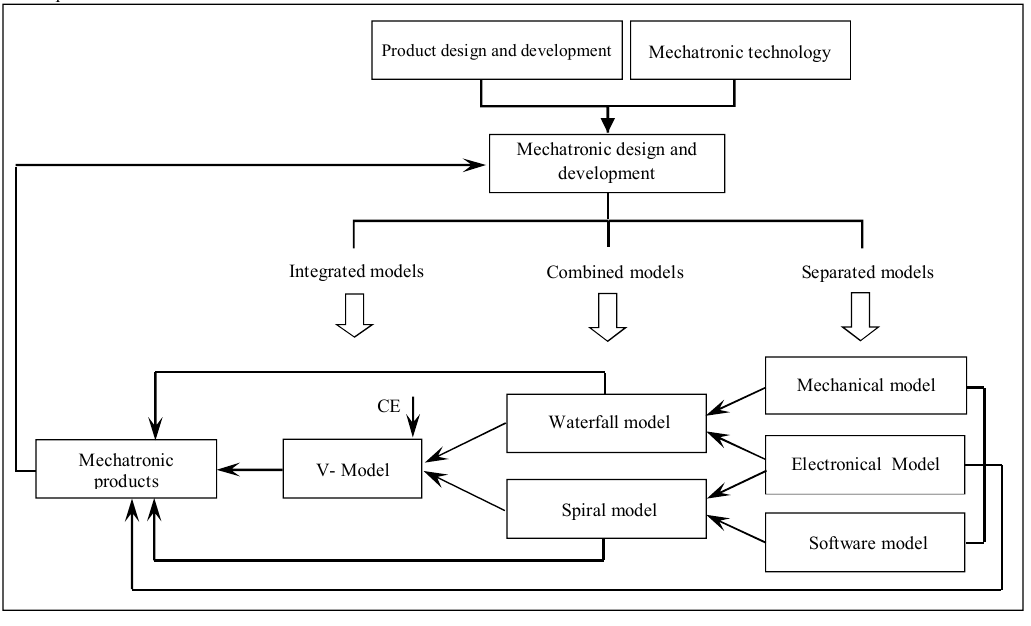
Fig. 1. Evolutionary trend of design and development models in mechatronics (Seyedhosseini &